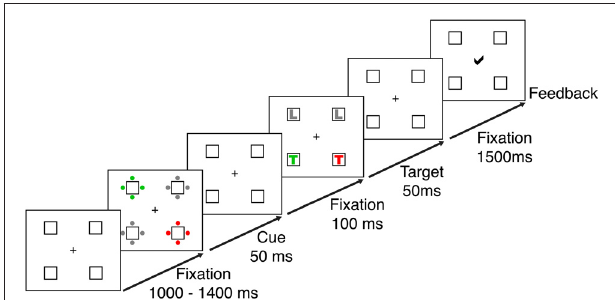
FIGURE 1 | Trial sequence for the contingent capture task. Each trial started with a fixation display, which was presented for a randomized interval of 1000–1400 ms. Cue and target displays appeared for 50 ms each and were separated by a 100 ms interval, during which the fixation display was presented. After the targets disappeared, participants had 1500 ms to respond to the target identity. At the end of the trial participants received visual feedback about the accuracy of their